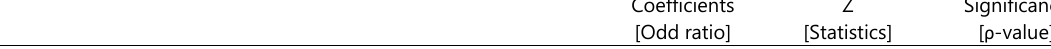
Coefficients [Odd ratio]